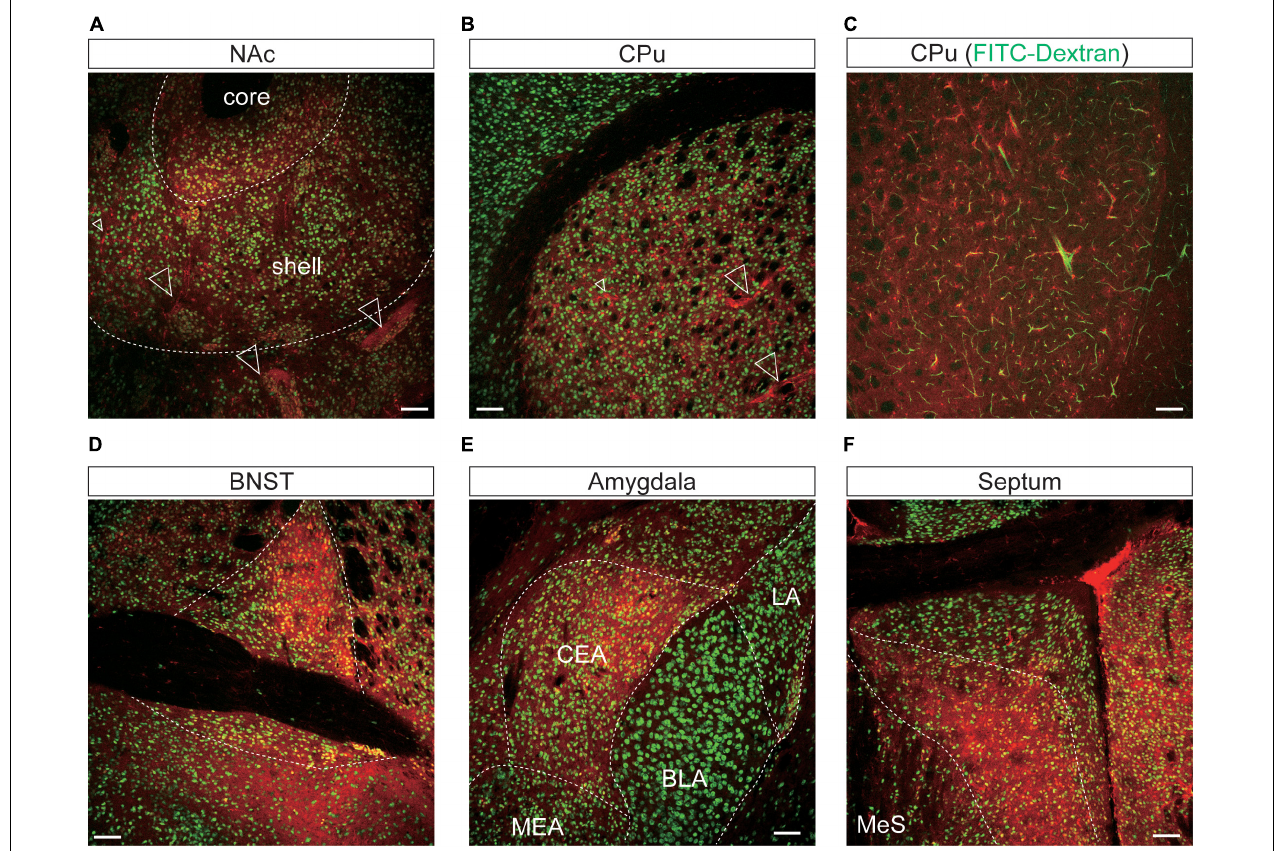
FIGURE 7 | Representative confocal images showing tdTomato fluorescence in the mesolimbic pathways of T1r2 -tdTomato mice. (A) Nucleus accumbens (NAc). The core and shell of the NAc are indicated, (B) caudate putamen (CPu), (C) caudate putamen. FITC-Dextran (green). (D) Bed nucleus of the stria terminalis (BNST). (E) In the amygdala, the central amygdala (CEA), medial amygdala (MEA), lateral amygdala (LA), and basolateral amygdala (BLA) are indicated. (F) Septal nuclei. White dotted lines indicate the borders of nearby areas. White empty triangles indicate vascular structures. Anti-NeuN signals [green except for panel (C) ]; tdTomato (red). Scale bar, 100 µ